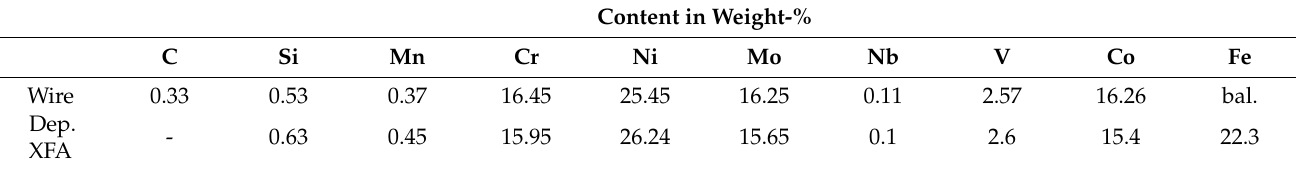
Table 3. Comparison of the nominal chemical composition and the chemical composition of the deposited